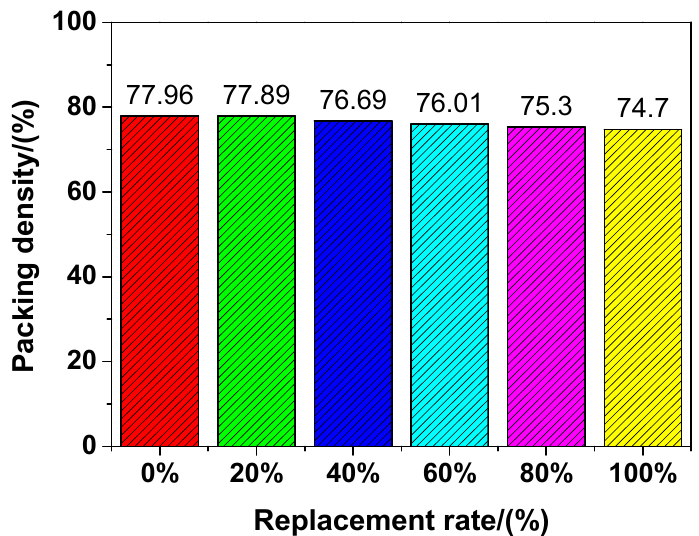
Figure 10. Maximum packing density of mixed fine aggregates.